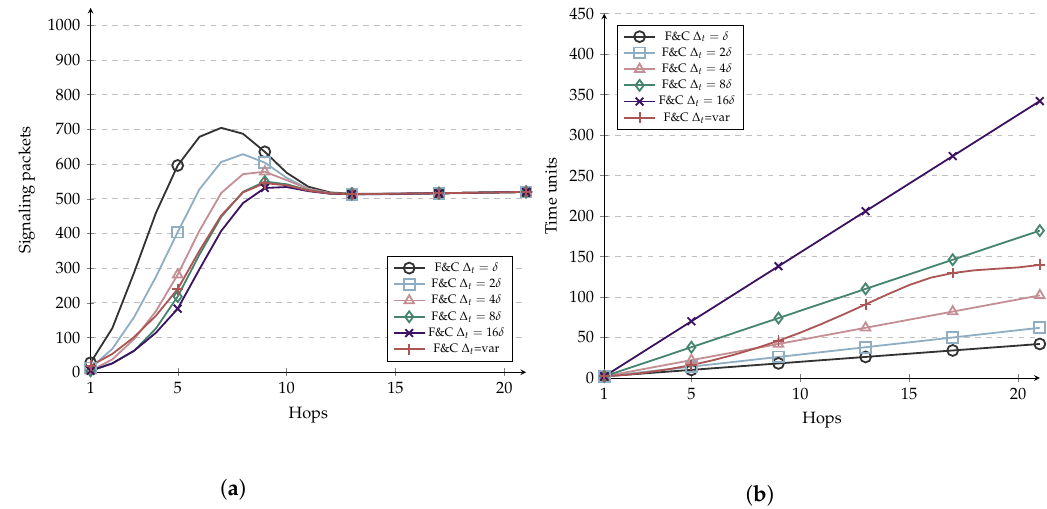
Figure 9. Comparison of F&C with different d . ( a ) Signaling overhead; ( b ) Resource discovery